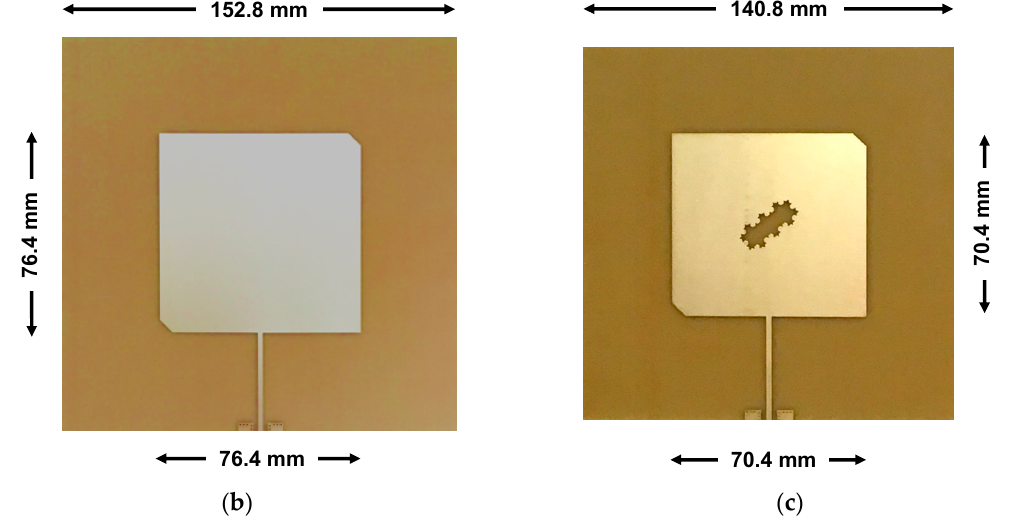
Figure 3. Proposed fractal-slot patch antenna: ( a ) computer-aided design drawing of a fractal slot consisting of three Koch snowflake patterns, obtained using the ANSYS HFSS 3D EM simulator; ( b ) fractal-slot patch antenna fabricated on an FR4 substrate; ( c ) conventional patch antenna on the same FR4 substrate.